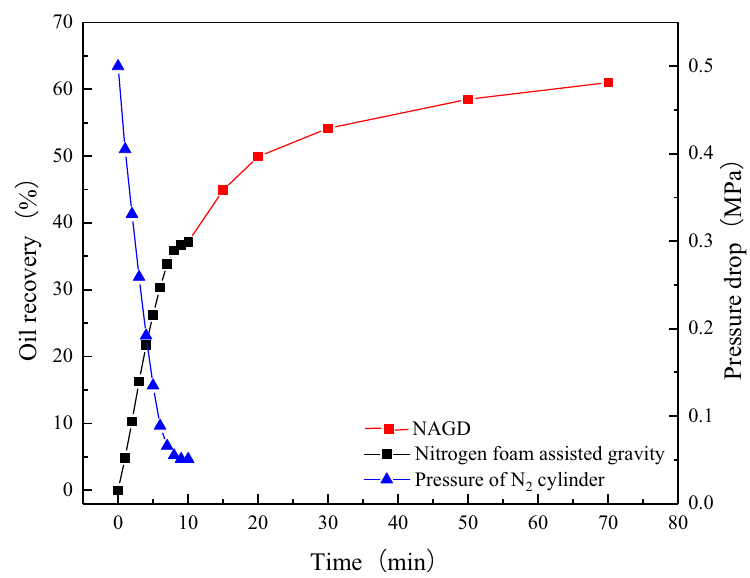
Fig. 10 Oil recovery and pres- sure drop curve of nitrogen and nitrogen foam-assisted gravity drainage (experiment condi- tion: temperature 80 °C,